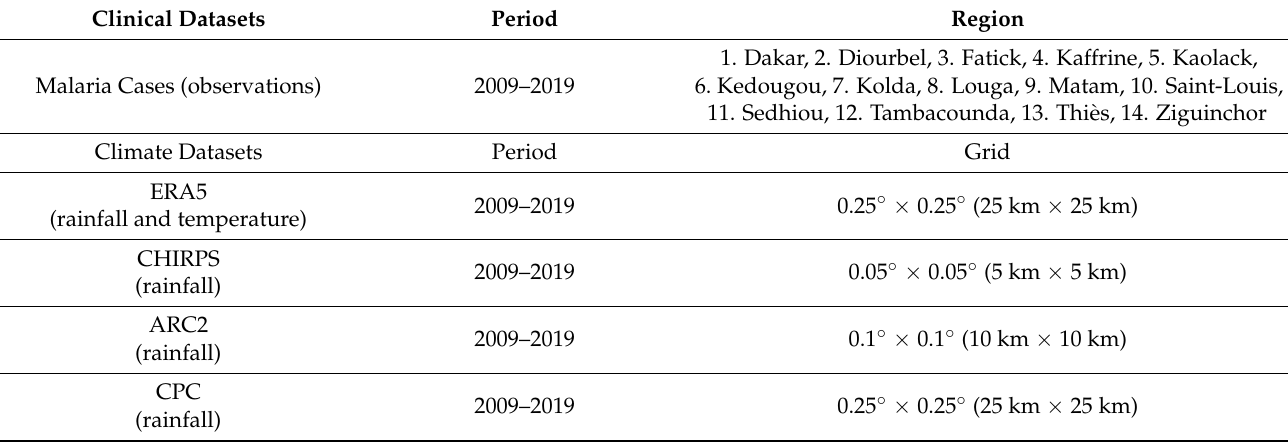
Figure 1. Map of Senegal with its fourteen administrative regions (at left): located in the far west of the African continent, Senegal is between latitudes 12 ◦ –17 ◦ N and longitudes 18 ◦ –11 ◦ W. Table 1. Datasets and stations: this table summarizes the available datasets, periods, and spatial resolution of gridded